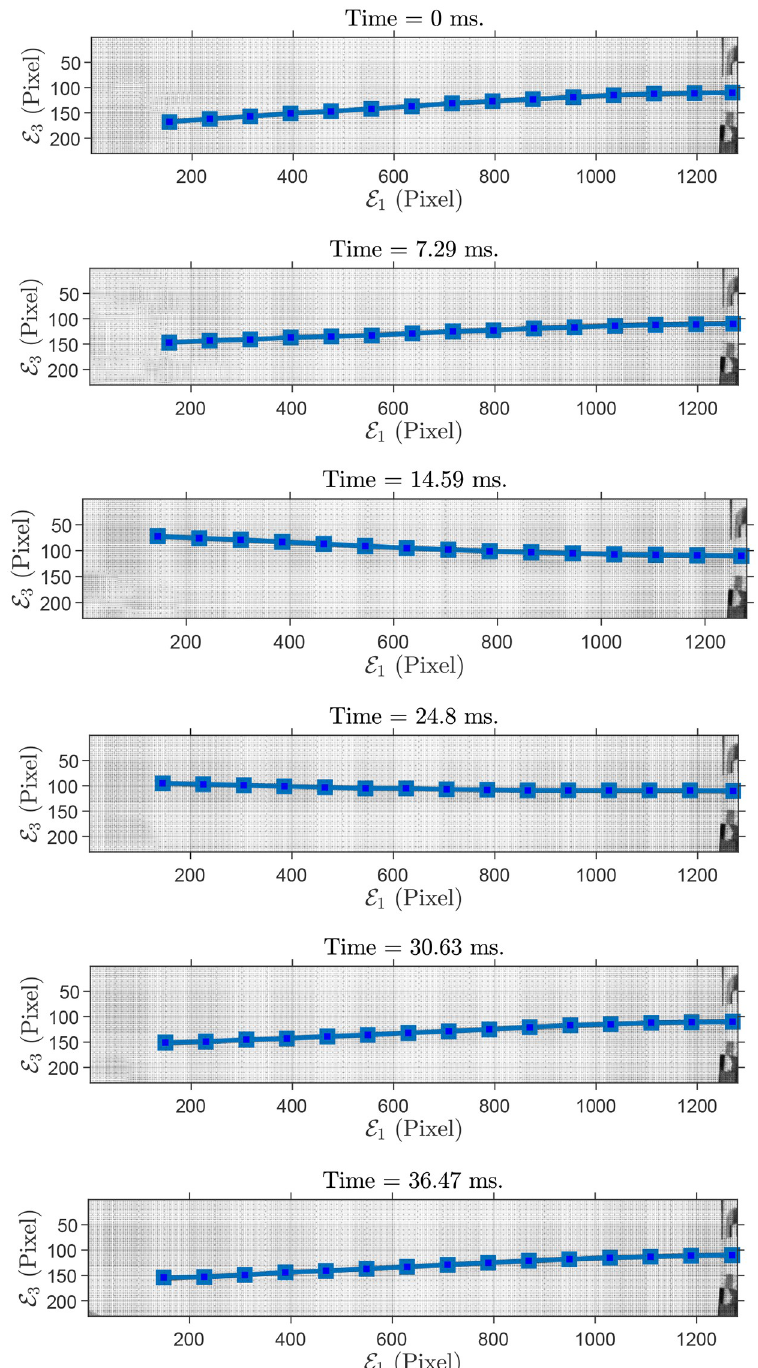
Fig 5. Sample of grabbed images of flexible rod (AlSi05) configurations, in-plane experiment ( E discretization nodes, depicted in blue squares, are superimposed on the flexible rod.